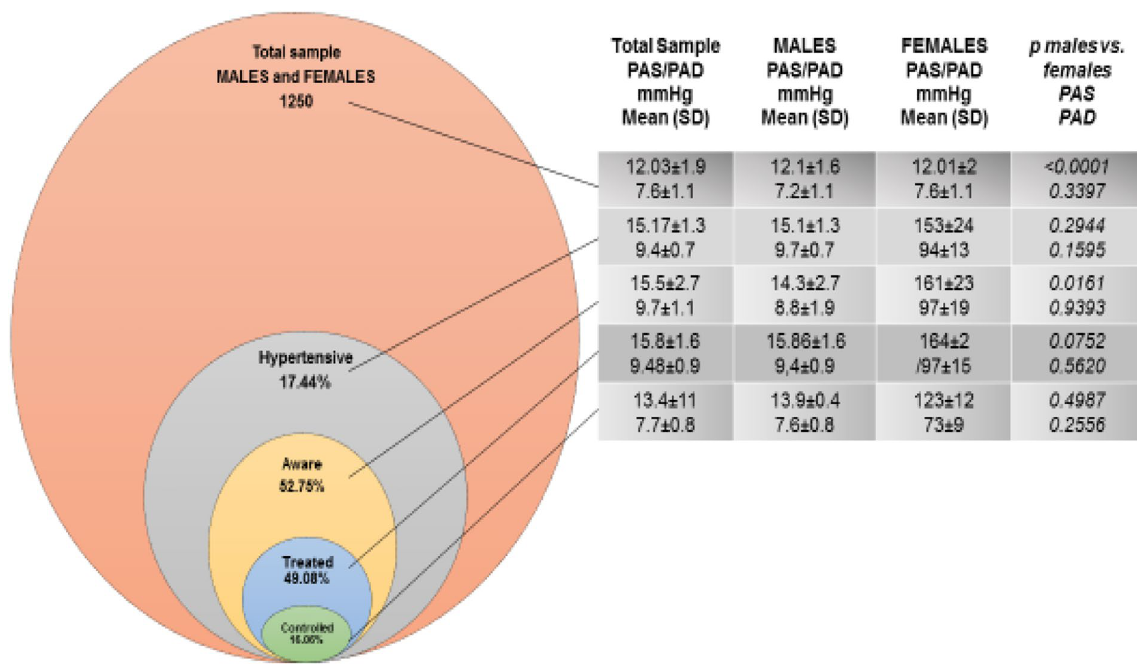
Figure 2. Prevalence and the proportion of treatment, controlled and awareness hypertension in study participants stratified to values of systolic and diastolic blood pressure in male and